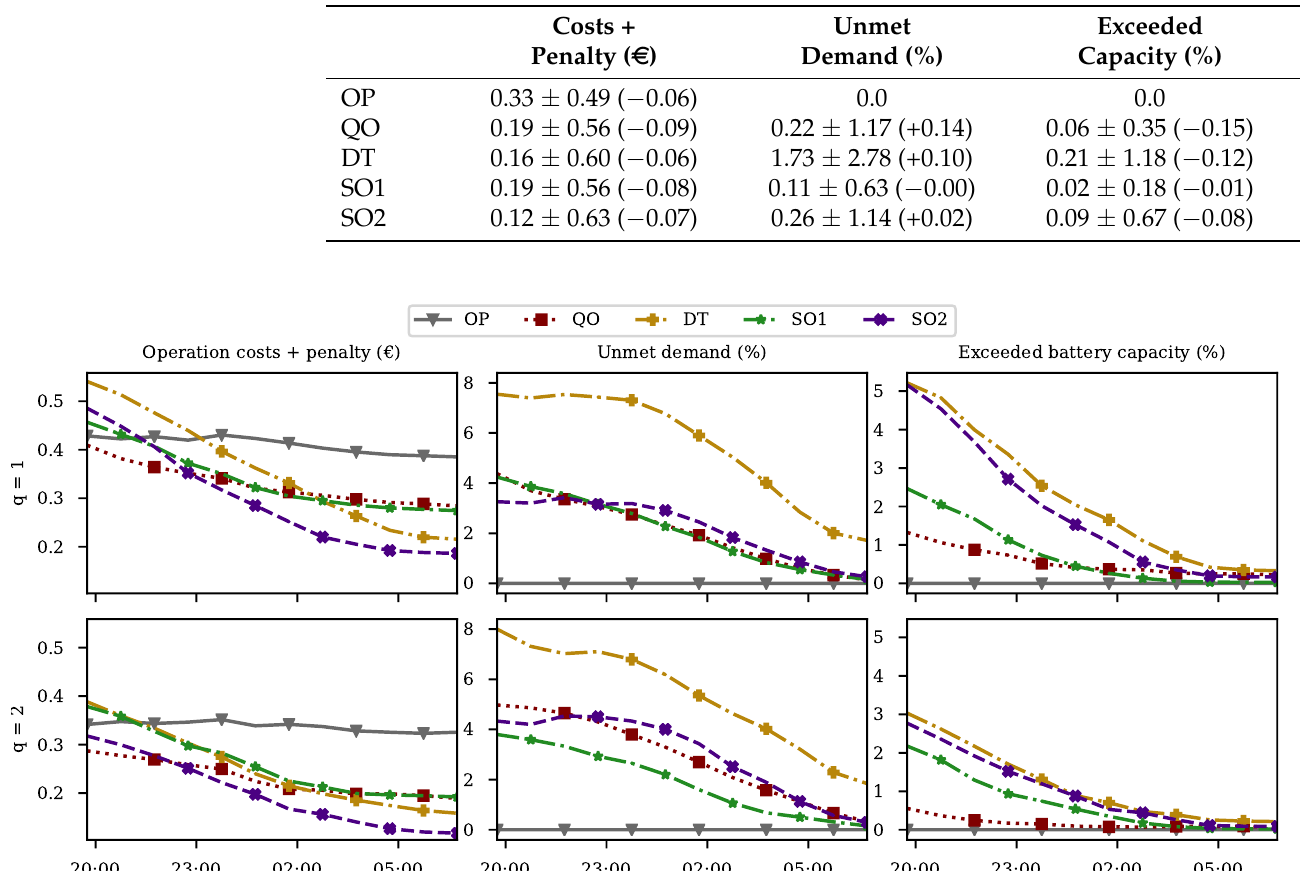
Table 4. Results for the controlled increasing forecast quality case. The values shown are the averages across all 950 scenarios for q = 2 ± the standard deviation, with the average difference between q = 2 and q = 1 in parentheses (see values in Table 3).